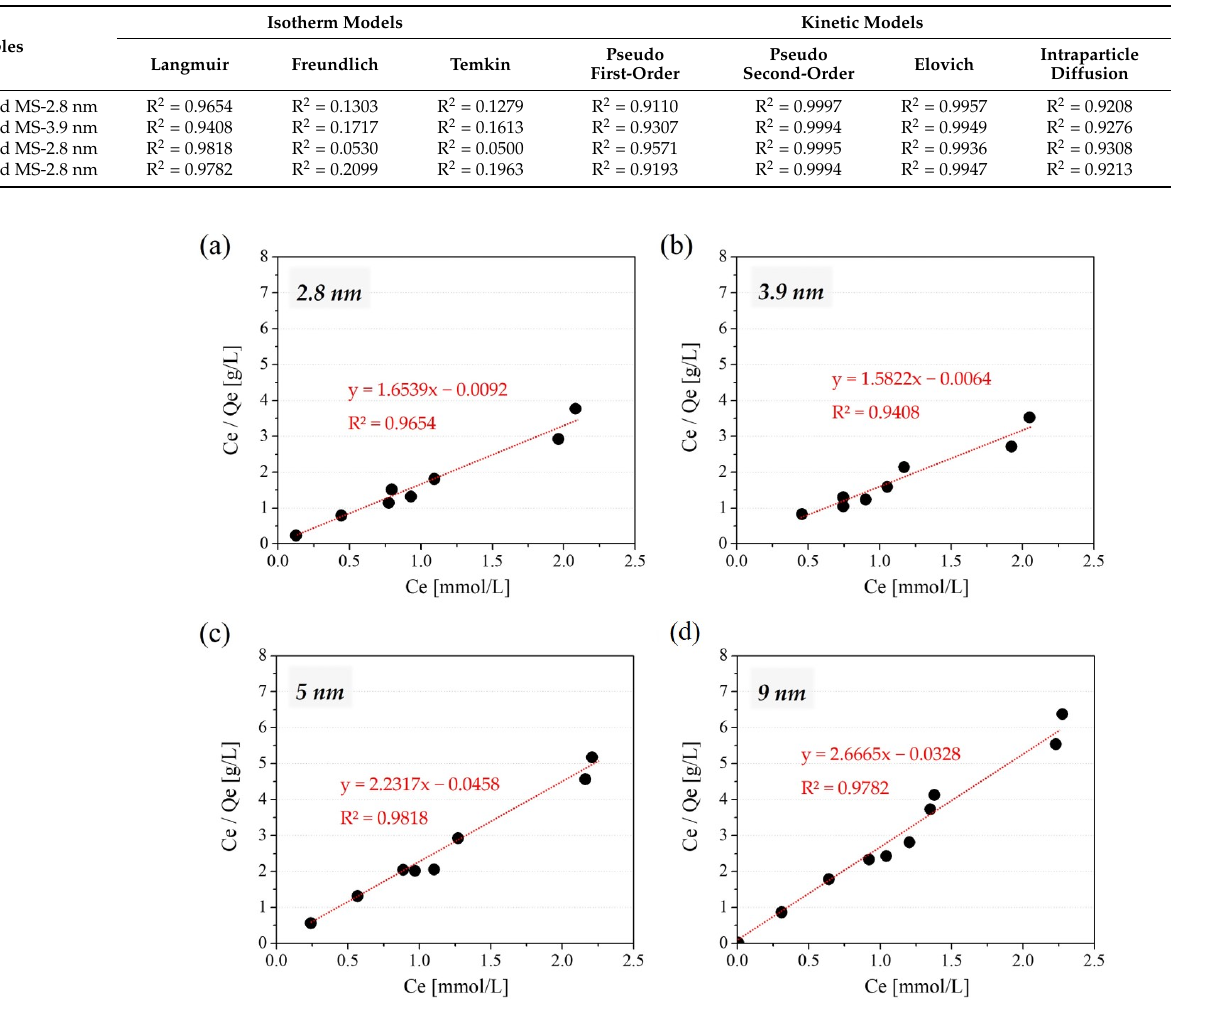
Figure 8. Pseudo second-order kinetic plot for Zn adsorption amount on amine-modified MS with the initial MS pore size of 2.8 nm ( a ), 3.9 nm ( b ), 5 nm ( c ), and 9 nm ( d ) in single-component system at various time intervals in the range of 10–1440 min.